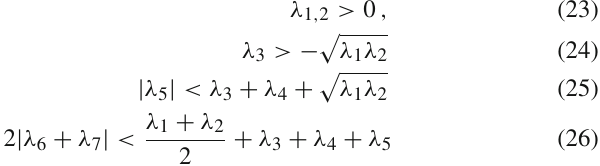
The region allowed by stability and perturbativity criteria has been shown in Fig. 3. For this purpose, we have per- formed a scan in the following range of parameters for sce- nario 1, where m h = 125 GeV and hard Z 2 -symmetry break- ing parameters λ 6 and λ 7 are assumed to be